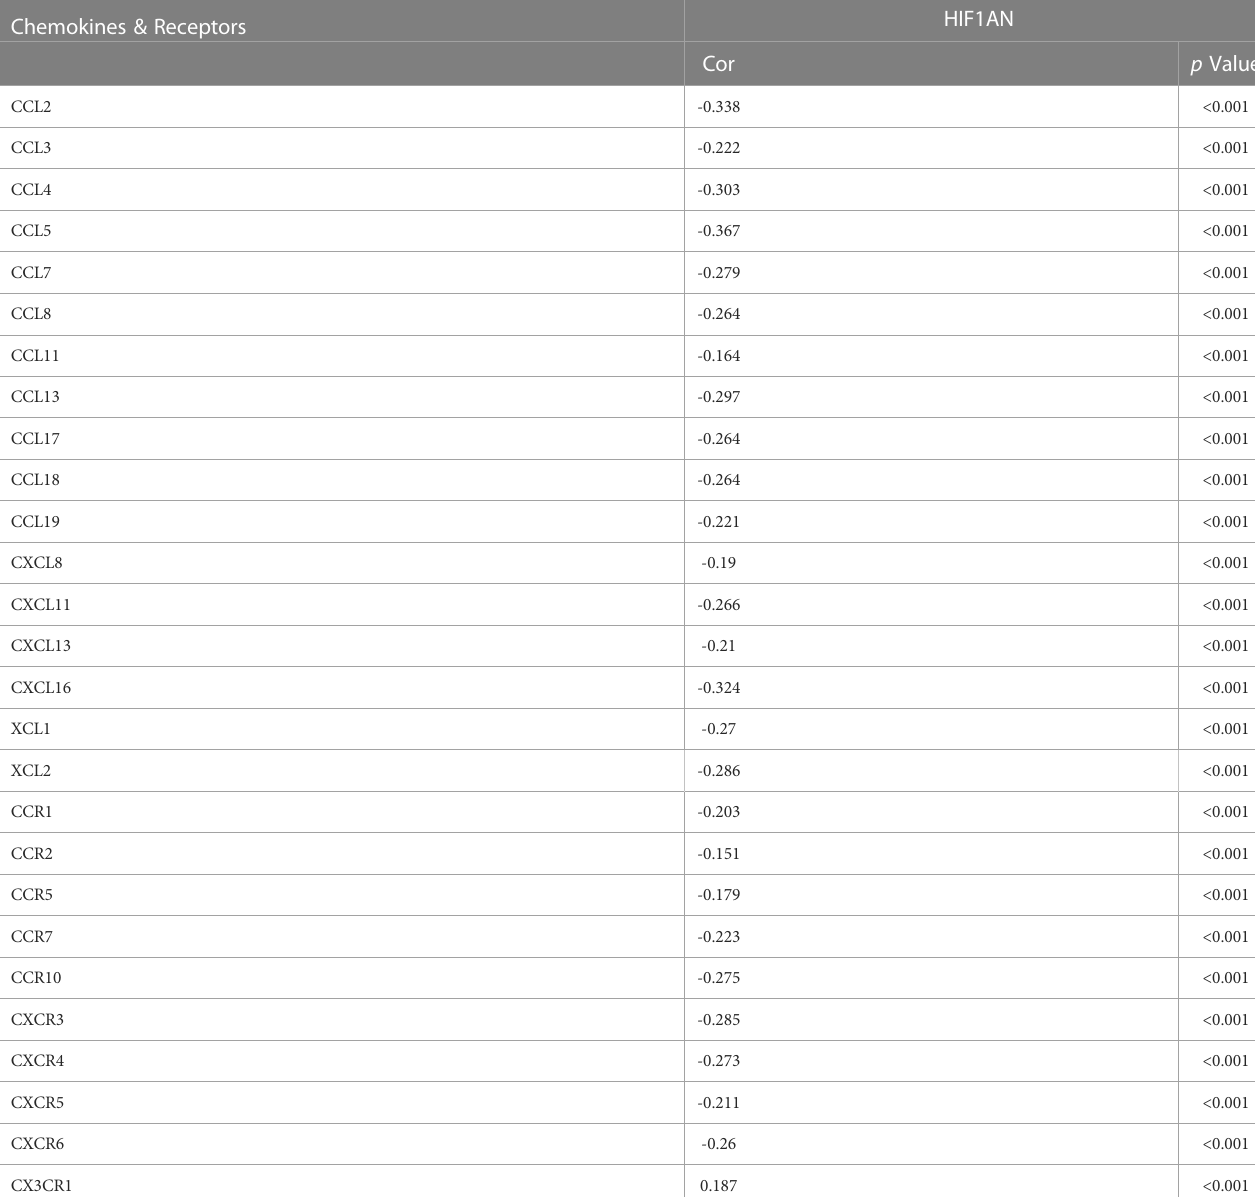
TABLE 1 Correlation analysis between the expression of HIF1AN and Chemokines & Receptors in breast cancer at TISIDB datasets. Chemokines &